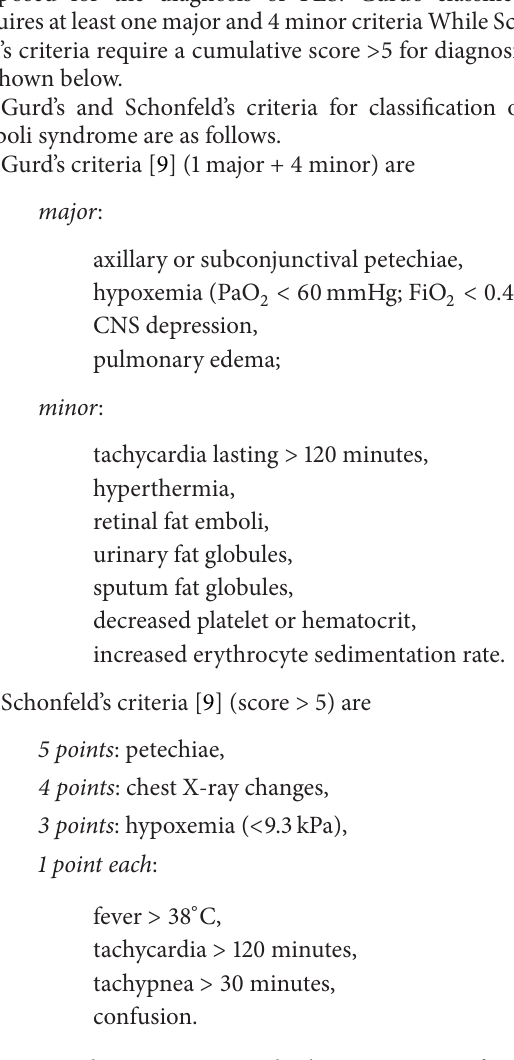
Figure 1: The lipid in the lung capillaries is staining positive with oil red O fat stain (20x original